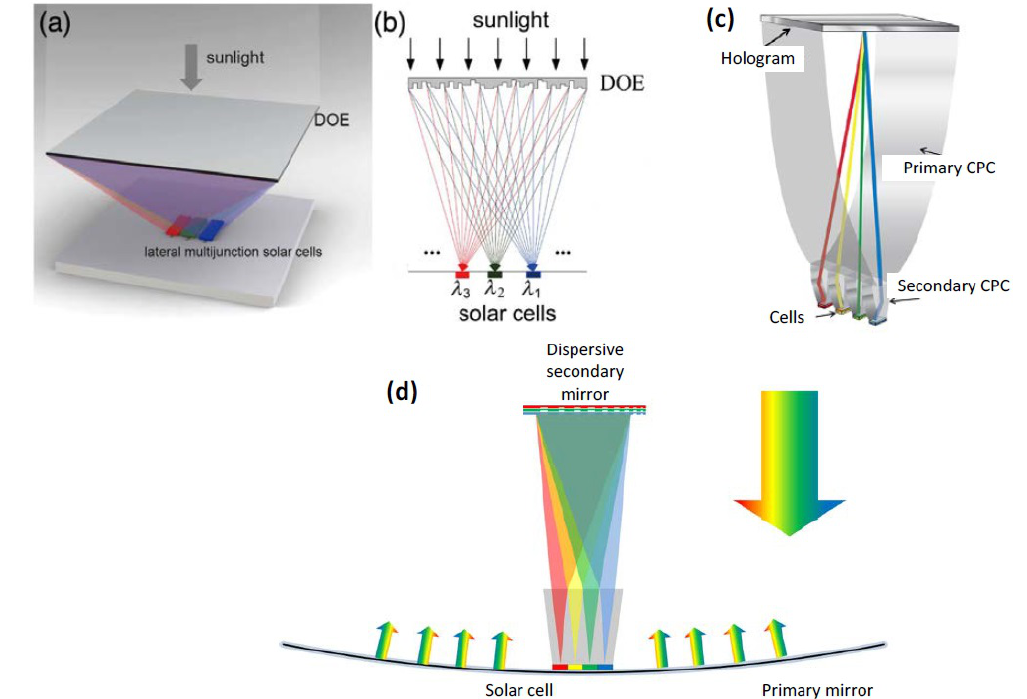
Figure 3: (a) A point-focusing DOE for lateral multijunction PV receiver [27]. (b) A one-dimensional DOE [27]. (c) One-dimensional DOE ac- companied with a CPC as a secondary concentrator [28]. (d) Applying DOE close to the focal region of a linear or dish concentrator under concentrated wide angle illumination